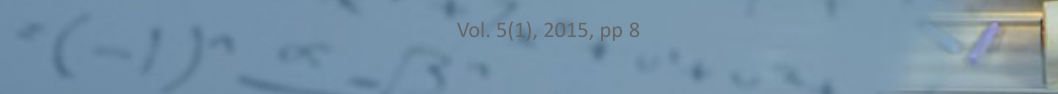
Vol. 5(1), 2015, pp